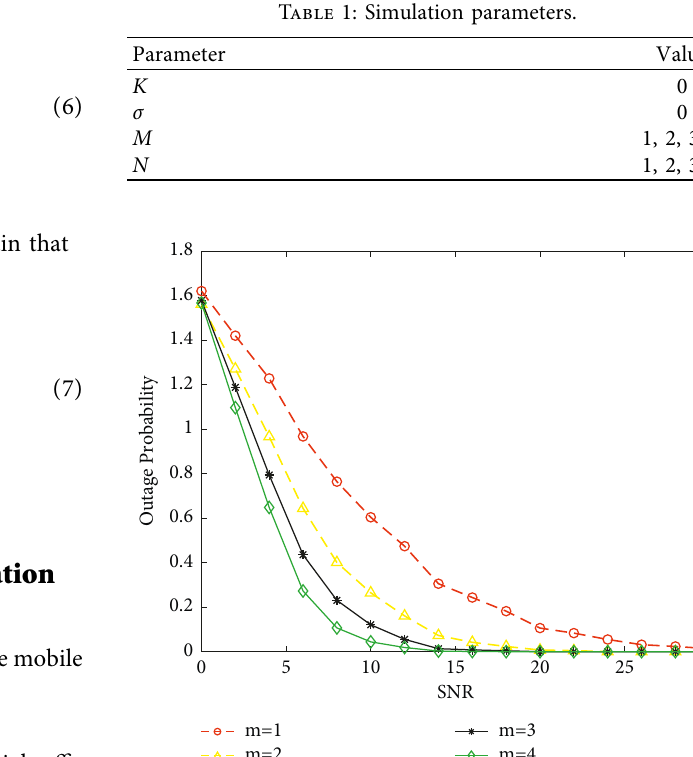
Figure 2: The OP performance with different ( m ).